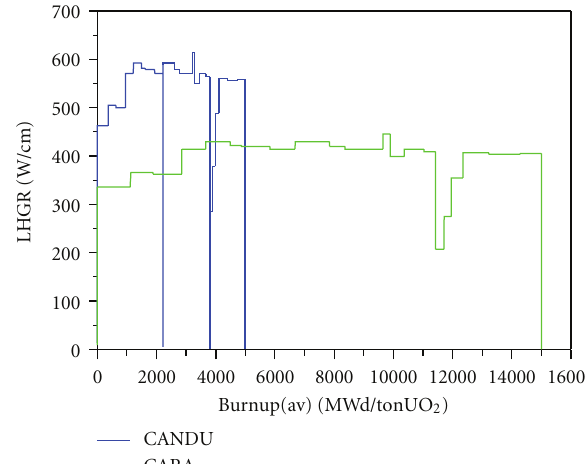
Figure 18: Local power history for the seventh segment of a fuel rod of the Atucha I NPP and a CARA fuel at that axial position in the